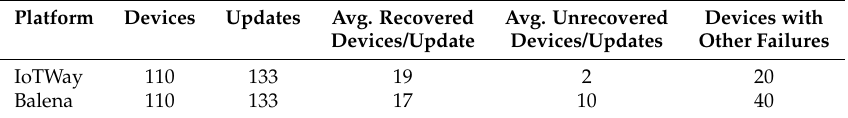
Table 6. Update performance comparison between IoTWay and